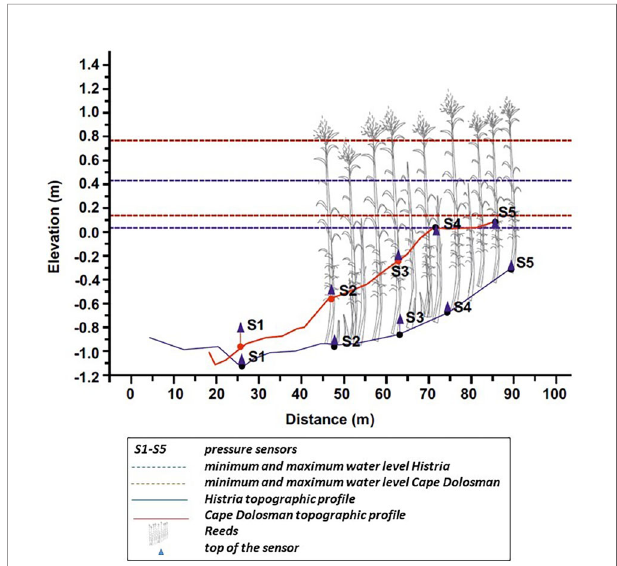
FIGURE 3 | Topographic pro fi les of the wave transects, showing the position of wave sensors, minimum and maximum water level measured at sensor S2 and the approximate extent of the vegetated